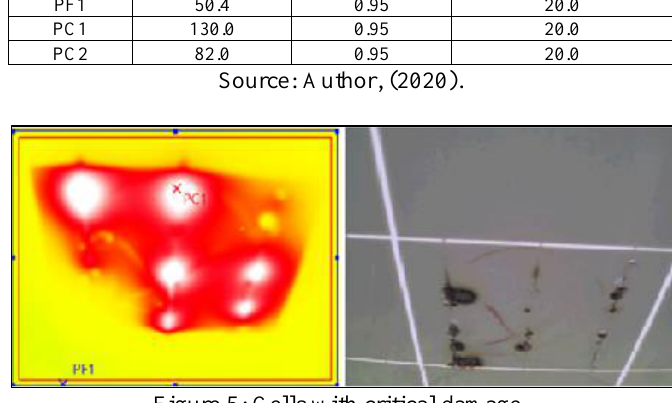
Figure 5: Cells with critical